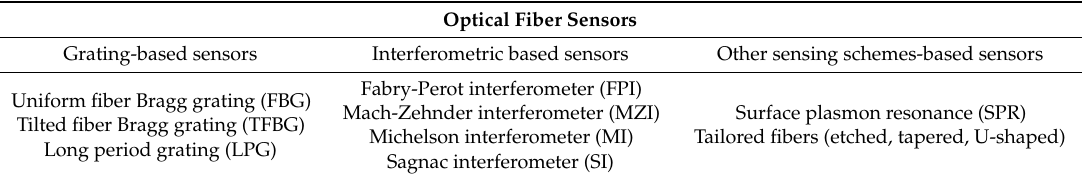
Table 1. Distribution of the optical fiber sensors discussed in this